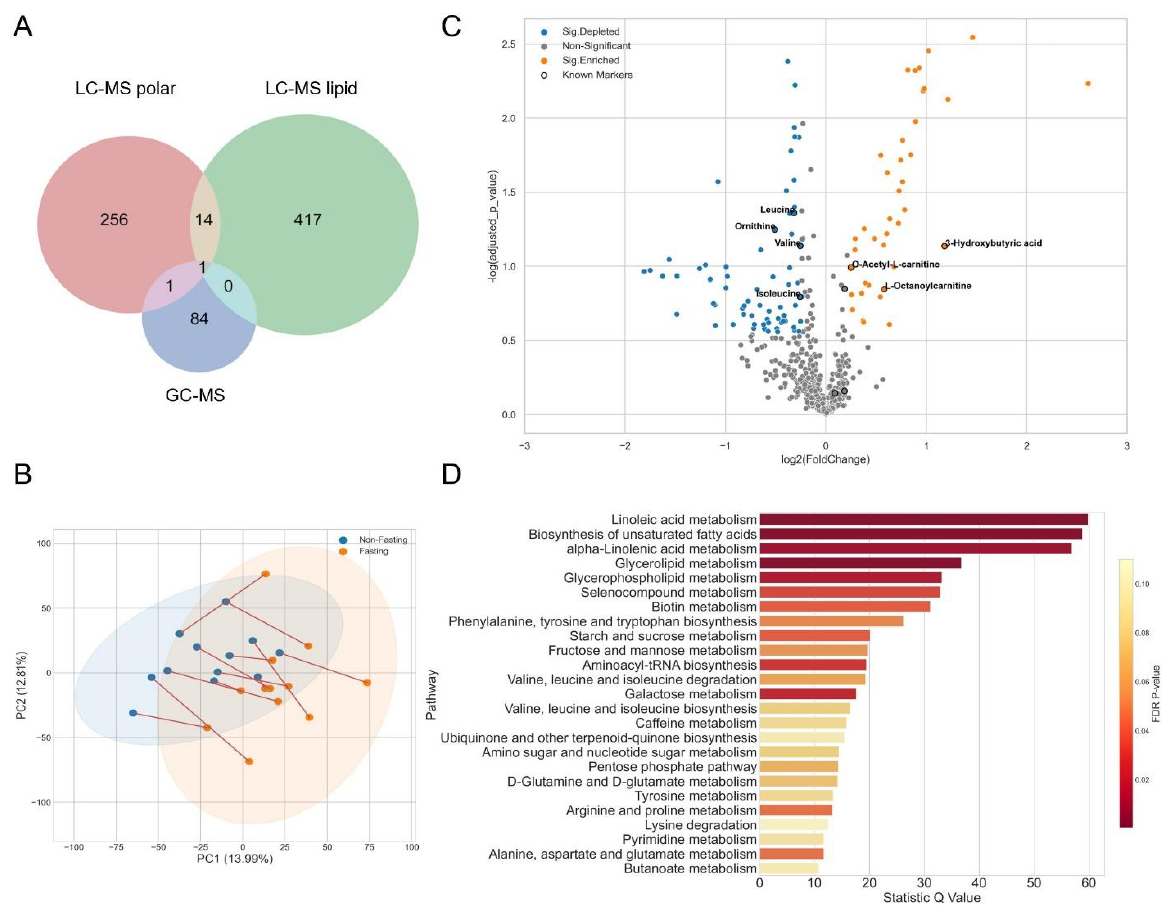
Figure 2. Metabolic profiles and comparisons of plasma samples from identical subjects in the fast- ing and non-fasting status. ( A ) Venn diagram of annotated metabolites from GC-MS and LC-MS (polar and lipid) platforms. ( B ) The PCA analysis of metabolic profiles of fasting (orange dots) and non-fasting (blue dots) samples from identical subjects (connected by red lines). The eclipses are the 95% confidence intervals. ( C ) Volcano plot of significantly changed metabolites on fasting status. |Log2(foldchange)| > 0.25, p value < 0.05. Orange dots: significantly accumulated metabolites; blue dots: significantly depleted metabolites; gray dots: non-significant; black circles: the well-known